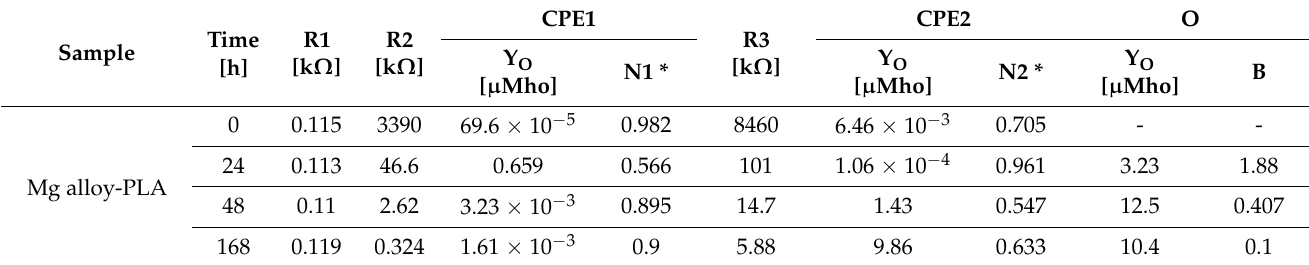
Table 6. Values from equivalents circuits Mg alloy-PLA.